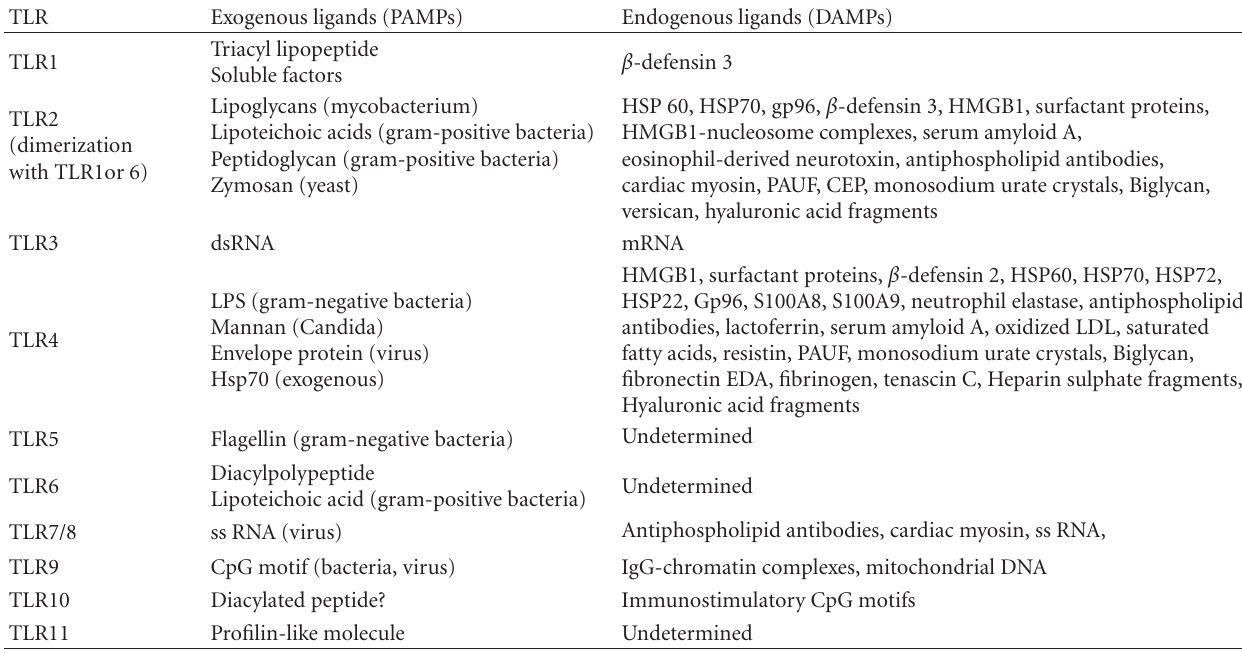
Table 1: Toll-like receptors and their corresponding